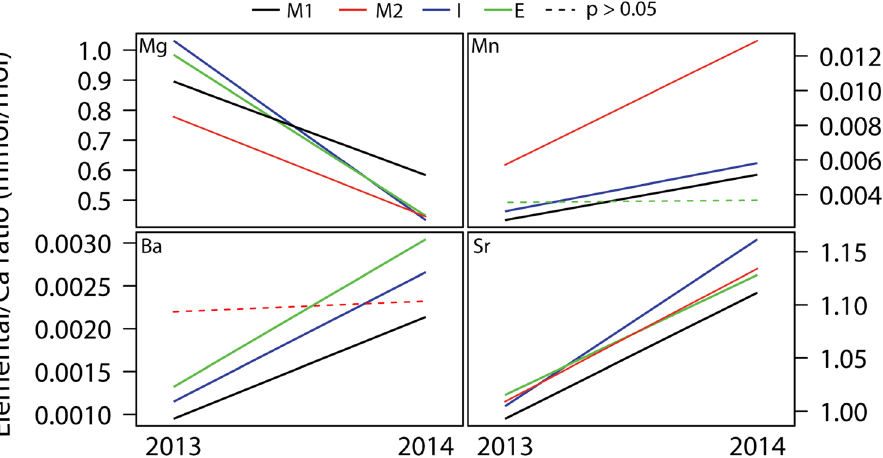
Figure 4. Evolution of elemental ratios of Mg, Mn, Ba and Sr in trace elements fingerprints (TEF) of cockle shells from 2013 to 2014 in areas: Mira Channel (M1 and M2), Ílhavo Channel (I) and Espinheiro Channel (E). The dotted lines represent significant differences in the elemental ratio between years ( p <